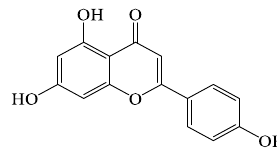
Figure 2 . Structure of Apigenin. Figure 2. Structure of